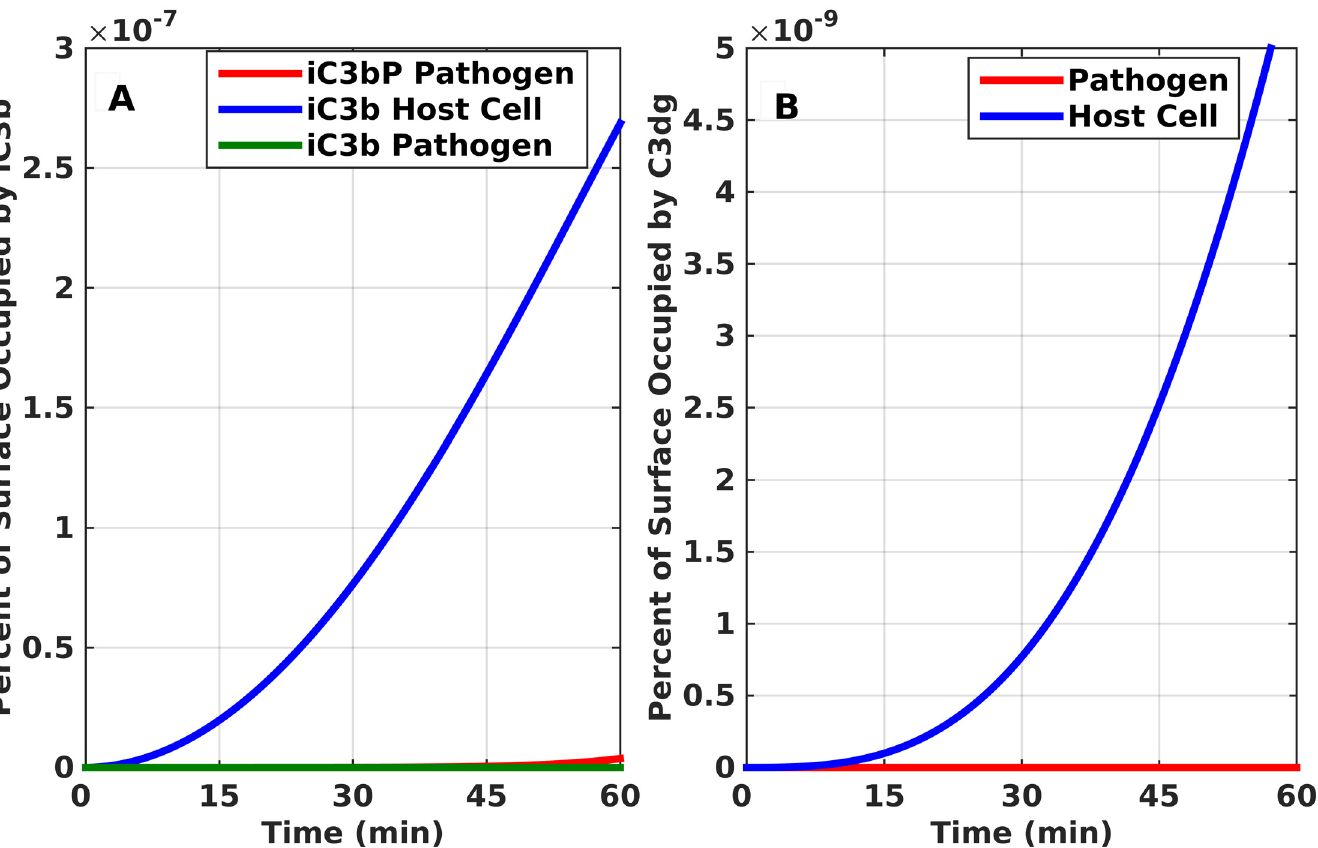
Fig 6. Time profile production for cleavage products of C3b. iC3b and C3dg. (A) iC3b. (B) C3dg. Both proteins take significantly less than 1 percent of pathogen and host cell